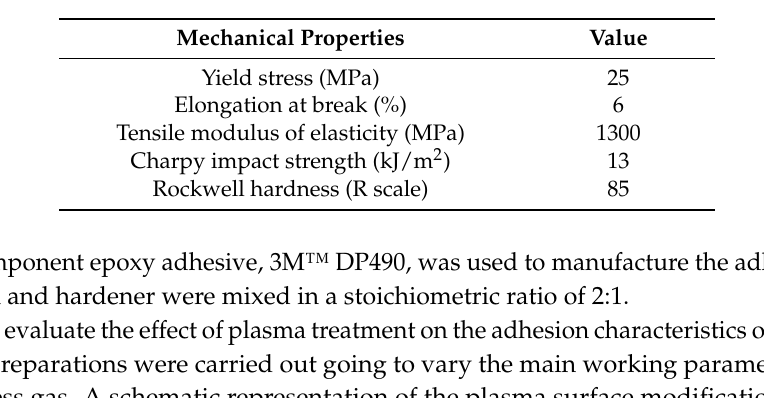
Table 1. Mechanical and thermal properties of the substrates used for the tests.